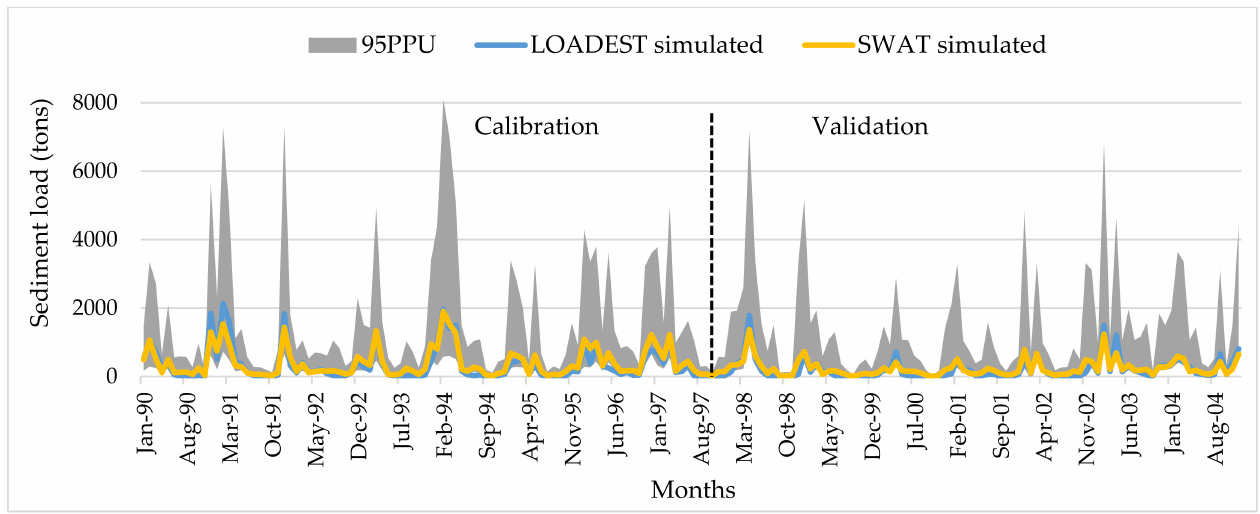
Figure 5. LOADEST simulated and SWAT simulated monthly sediment hydrograph with 95% prediction uncertainty (95PPU) at the watershed outlet for Calibration (1990–1997) and Validation (1998–2004)